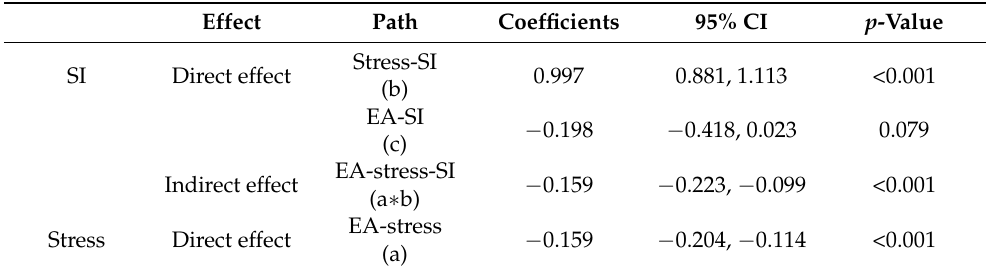
Table 3. The mediation effect of stress on the relationship between extracurricular activities and suicidal